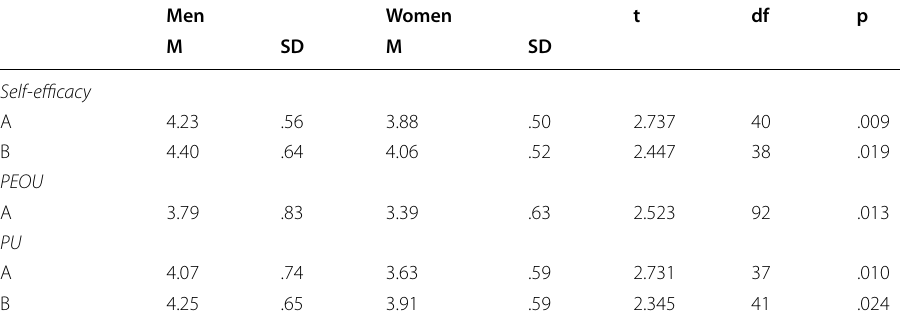
Table 7 Significant differences with respect to gender Men